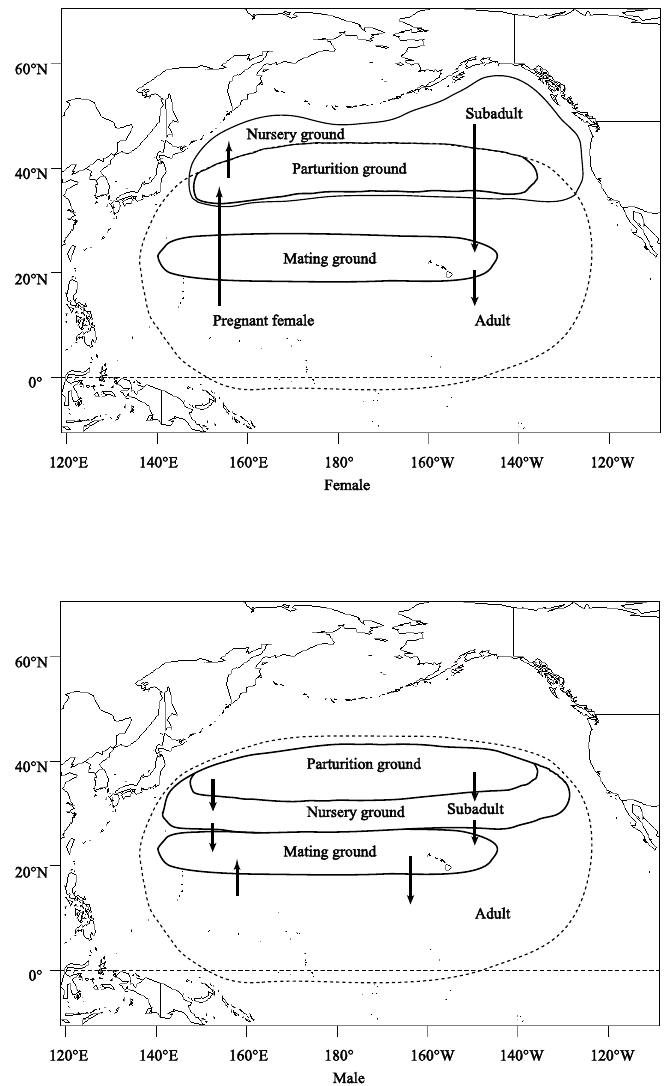
Figure 1. Life stages and sex segregation in North Pacific Ocean [22].